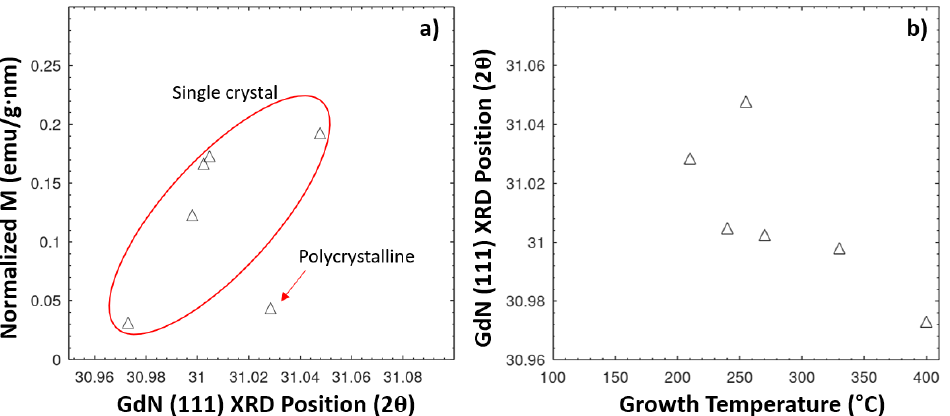
Figure 7. Thickness-normalized magnetization as a function of GdN (111) 2 θ peak position ( a ), and GdN (111) 2 θ as a function of growth temperature ( b ). Note that the samples showing single-crystal layer-by-layer growth (supported by RHEED measurements) show a correlation with increased magnetization for increased 2 θ (departing literature bulk value, indicating more stress in the film); the polycrystalline sample (grown at 210 °C) departs from this correlation.